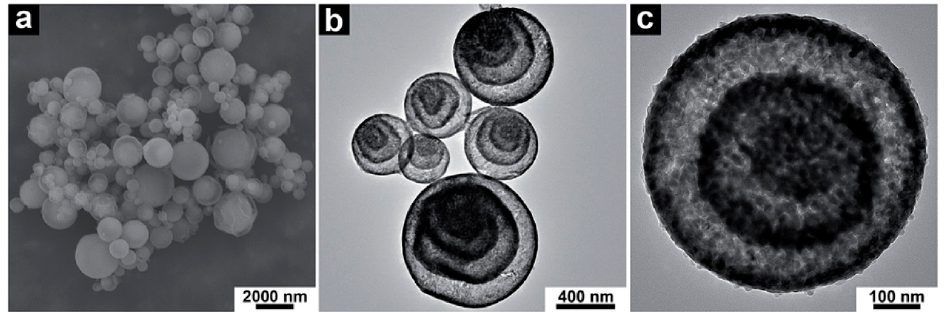
Figure 12. Hematite Fe 2 O 3 multi-shelled hollow spheres obtained by heat treatment of precursors spray-dried from an iron(III) citrate and sucrose solution: ( a ) SEM image; ( b , c ) TEM images. (Adapted from [107] with permission of The Royal Society of Chemistry).